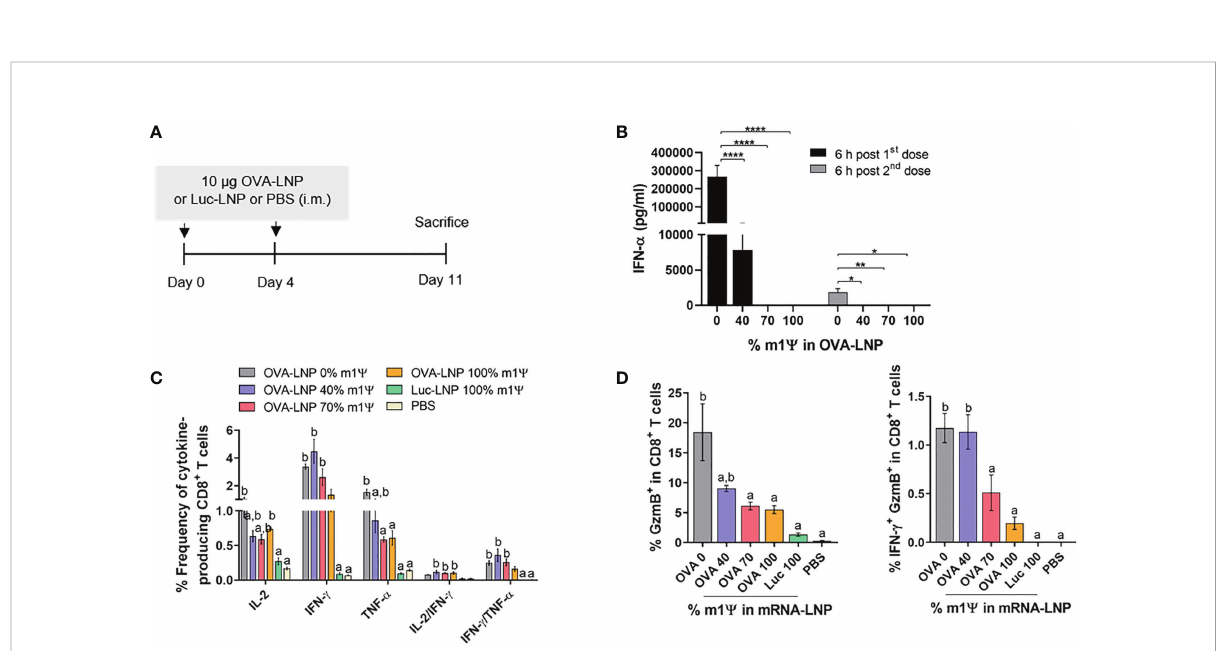
FIGURE 3 Immunization of mRNA-LNP elicits robust antigen-speci fi c CD8 + T cell responses. (A) Schematic representation of the immunization regimen (see methods for details). (B) IFN- a concentration in the serum 6 hr after the fi rst (day0) and the second (day4) immunizations of OVA mRNA-LNP were detected by ELISA. (C, D) The frequencies of IL-2, IFN g , TNF a and Granzyme B (GzmB) and IFN- g /GzmB-producing CD8 + T cells after 6 hr stimulation with OVA 257-264 (SIINFEKL) were measured by fl ow cytometry. The results are presented as the mean ± SEM, n = 4-5 biologically independent mice per group. Statistical signi fi cance: Statistical signi fi cance by one-way ANOVA with Bonferroni multiple comparisons test were indicated as (*) p < 0.05, (**)p < 0.01 and (****) p < 0.0001 or p < 0.05 compared to the unmodi fi ed target antigen: a, or control (PBS):